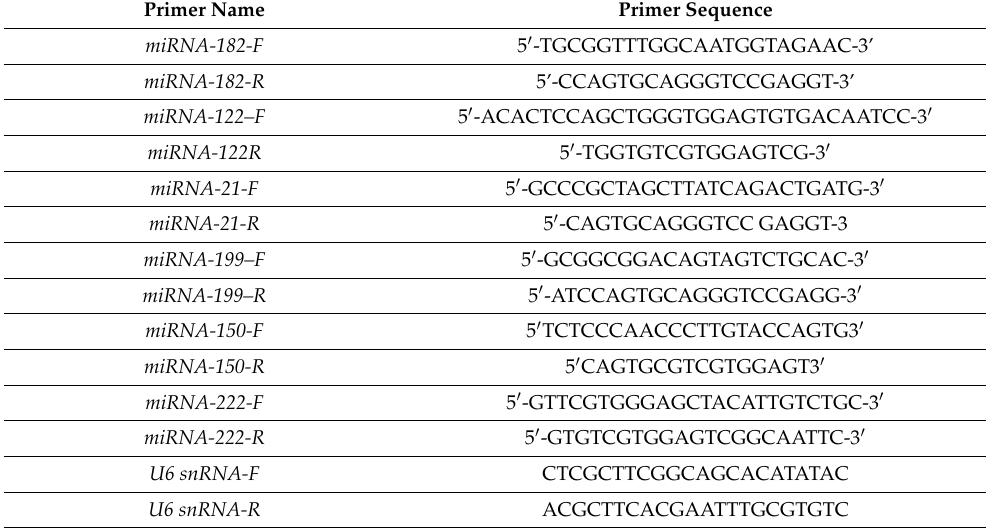
Table 1. Primers of miRNAs (miRNA-182, miRNA-122, miRNA-21, miRNA-199, miRNA-150, and